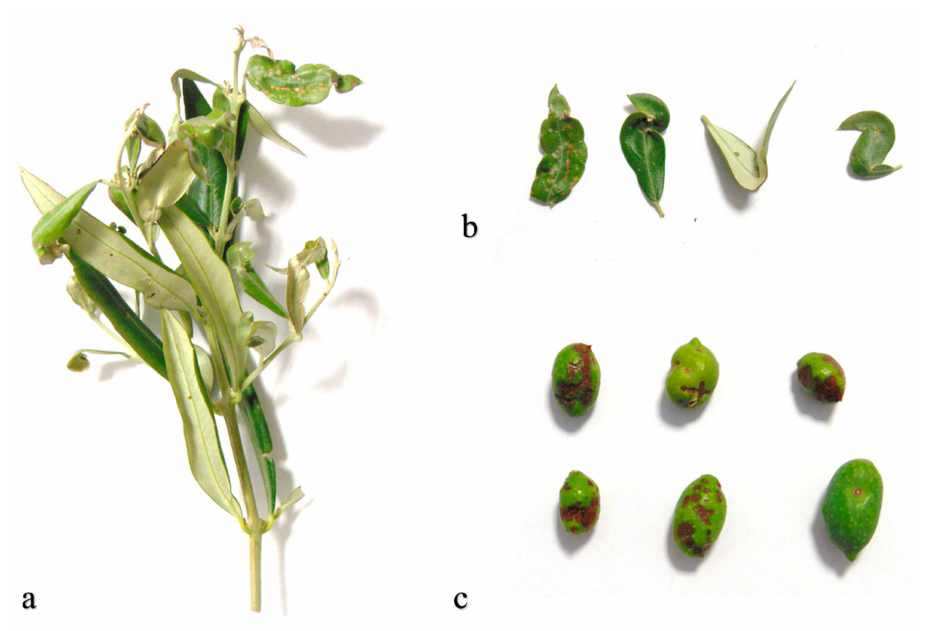
Figure 1. ( a ) Damage to new shoots; ( b ) damage to leaves; ( c ) damage to olive fruits.